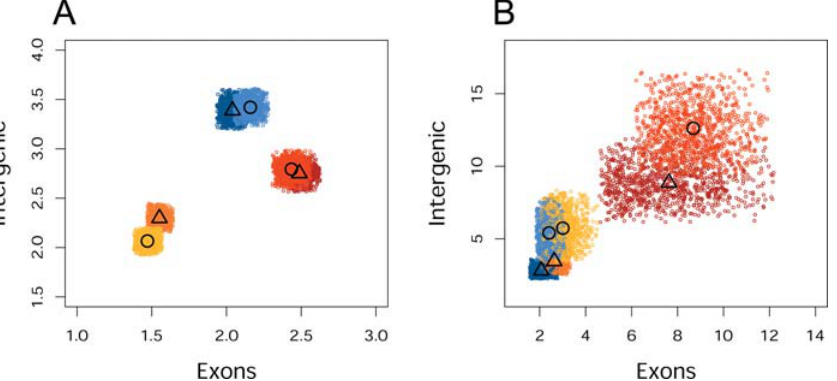
Figure 5. Expression Divergence and Divergence-to-Diversity Ratio in the Three Tissues for Exonic and Intergenic Probes Shown are the average expression divergence (A) and divergence-to-diversity ratio (B) between humans and chimpanzees in brain (yellow), heart (blue), and testis (red) for exonic and intergenic probes. The colored areas indicate 95% confidence intervals based on bootstrapping 1,000 subsets of exonic and intergenic probes, having the same number of probes from each category and the same signal intensity distribution. The darker shades indicate expression from the positive DNA strand, while the lighter shades indicate expression from the negative DNA strand. The symbols represent the mean value for each tissue on either the positive ( n ) or the negative ( * ) strand, respectively. DOI: 10.1371/journal.pgen.0020171.g005